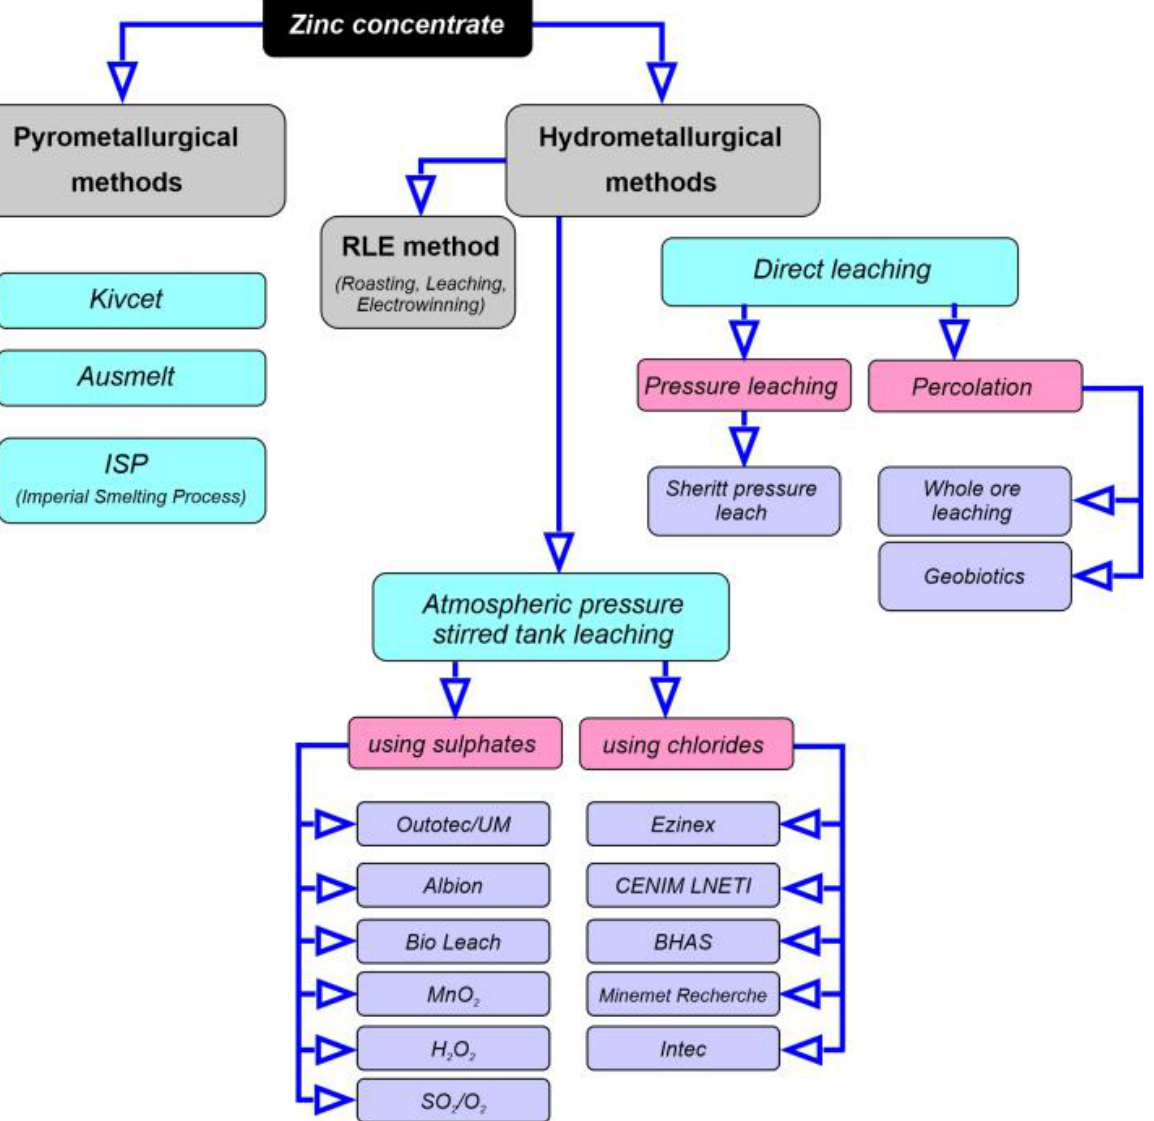
Figure 6. Available methods of processing zinc ores, figure prepared based on data taken from [56,57].